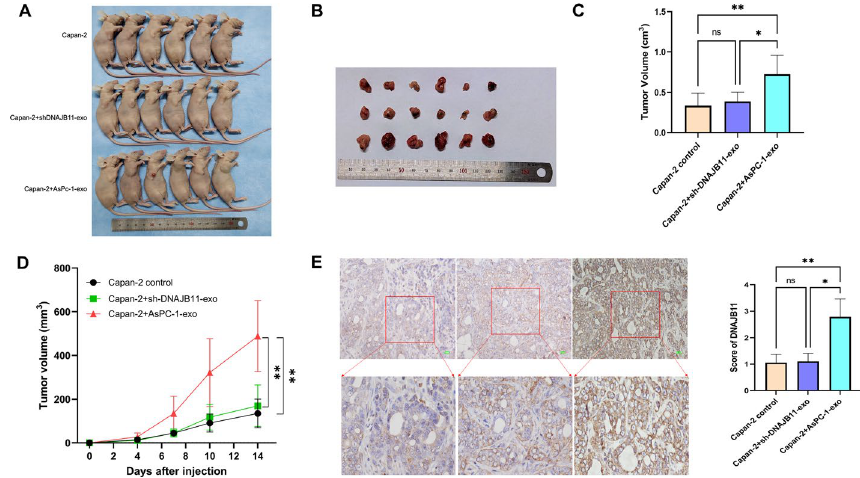
Fig. 7 Exosomal DNAJB11 promotes pancreatic cancer growth in a xenograft model. A Subcutaneously implanted tumor 2 weeks after initial implantation. B Surgically excised tumor tissue. C Statistical analysis of the weight of the subcutaneously implanted tumor. D Growth curve of subcutaneously implanted tumors. E Representative image of immunofluorescence staining of DNAJB11 in a paraffin-embedded excised tumor tissue section. * P < 0.05, ** P < 0.01; *** P < 0.001, one-way